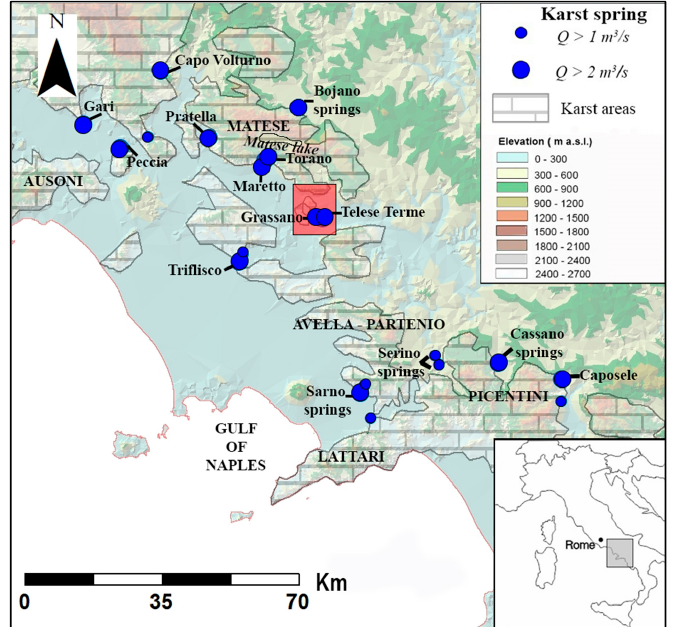
Figure 2. Hydrogeological overview of the western sector of Campania. Red rectangle shows the study area. study area.